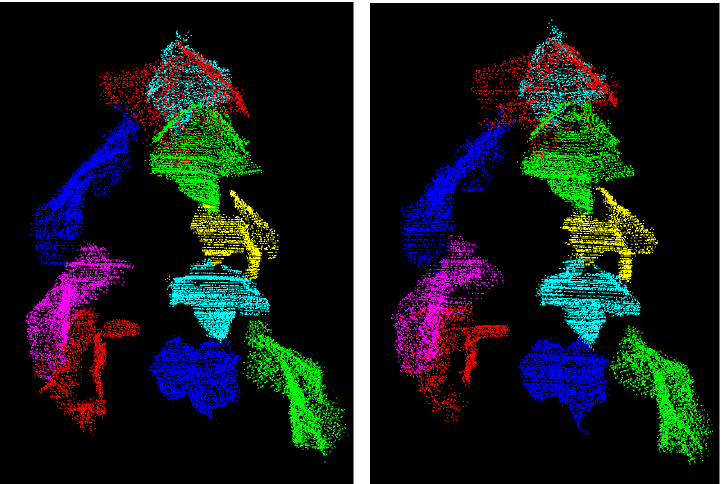
Figure 11. Temporal segmentation of two point clouds of the same plant. Points having the same colour belong to the same